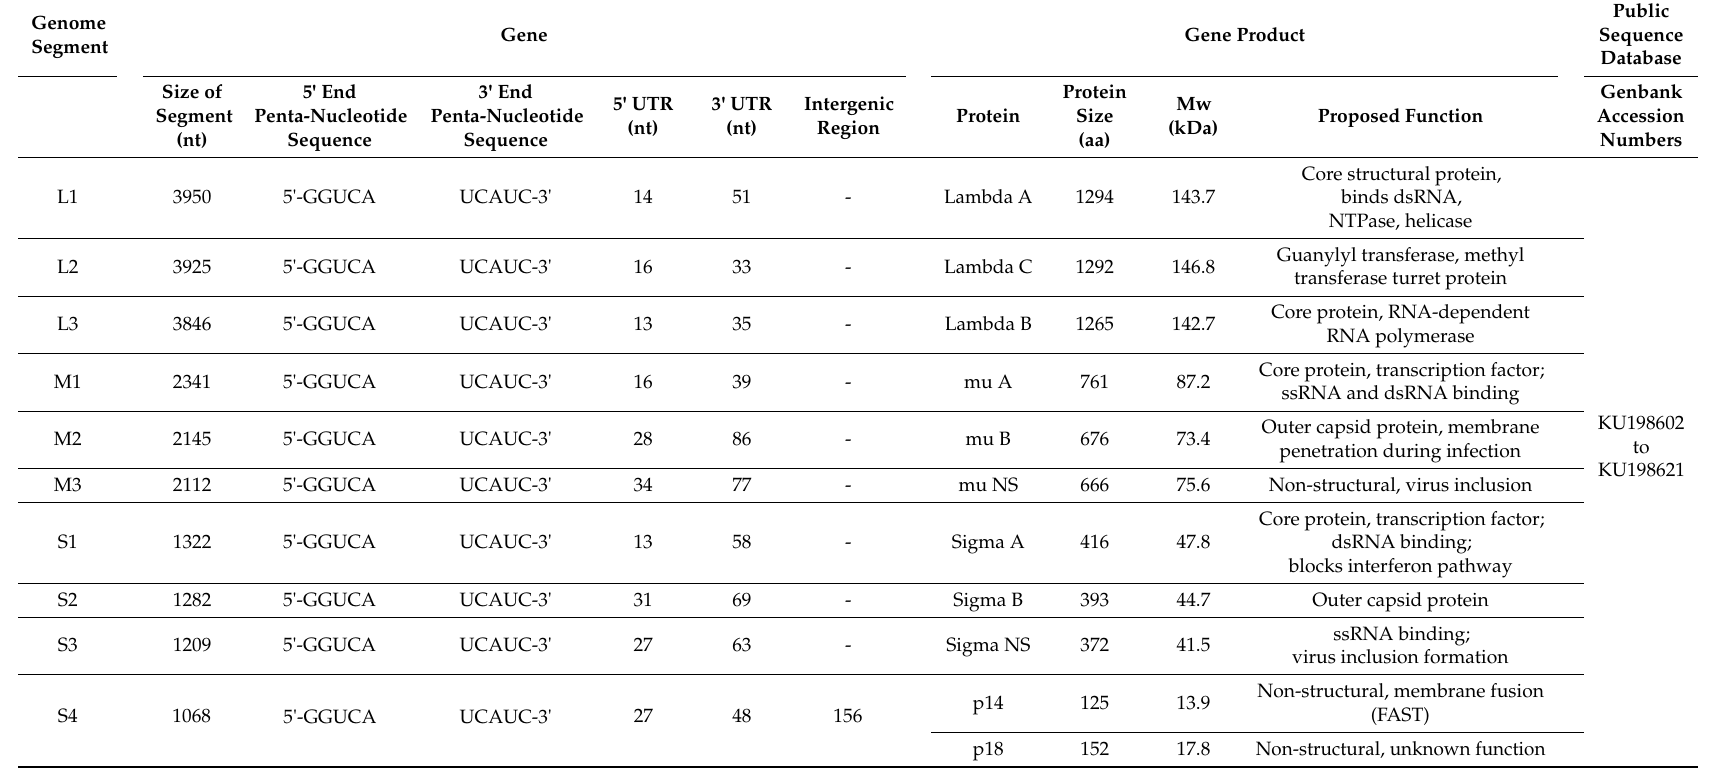
Table 4. MAHLV genome characterization per